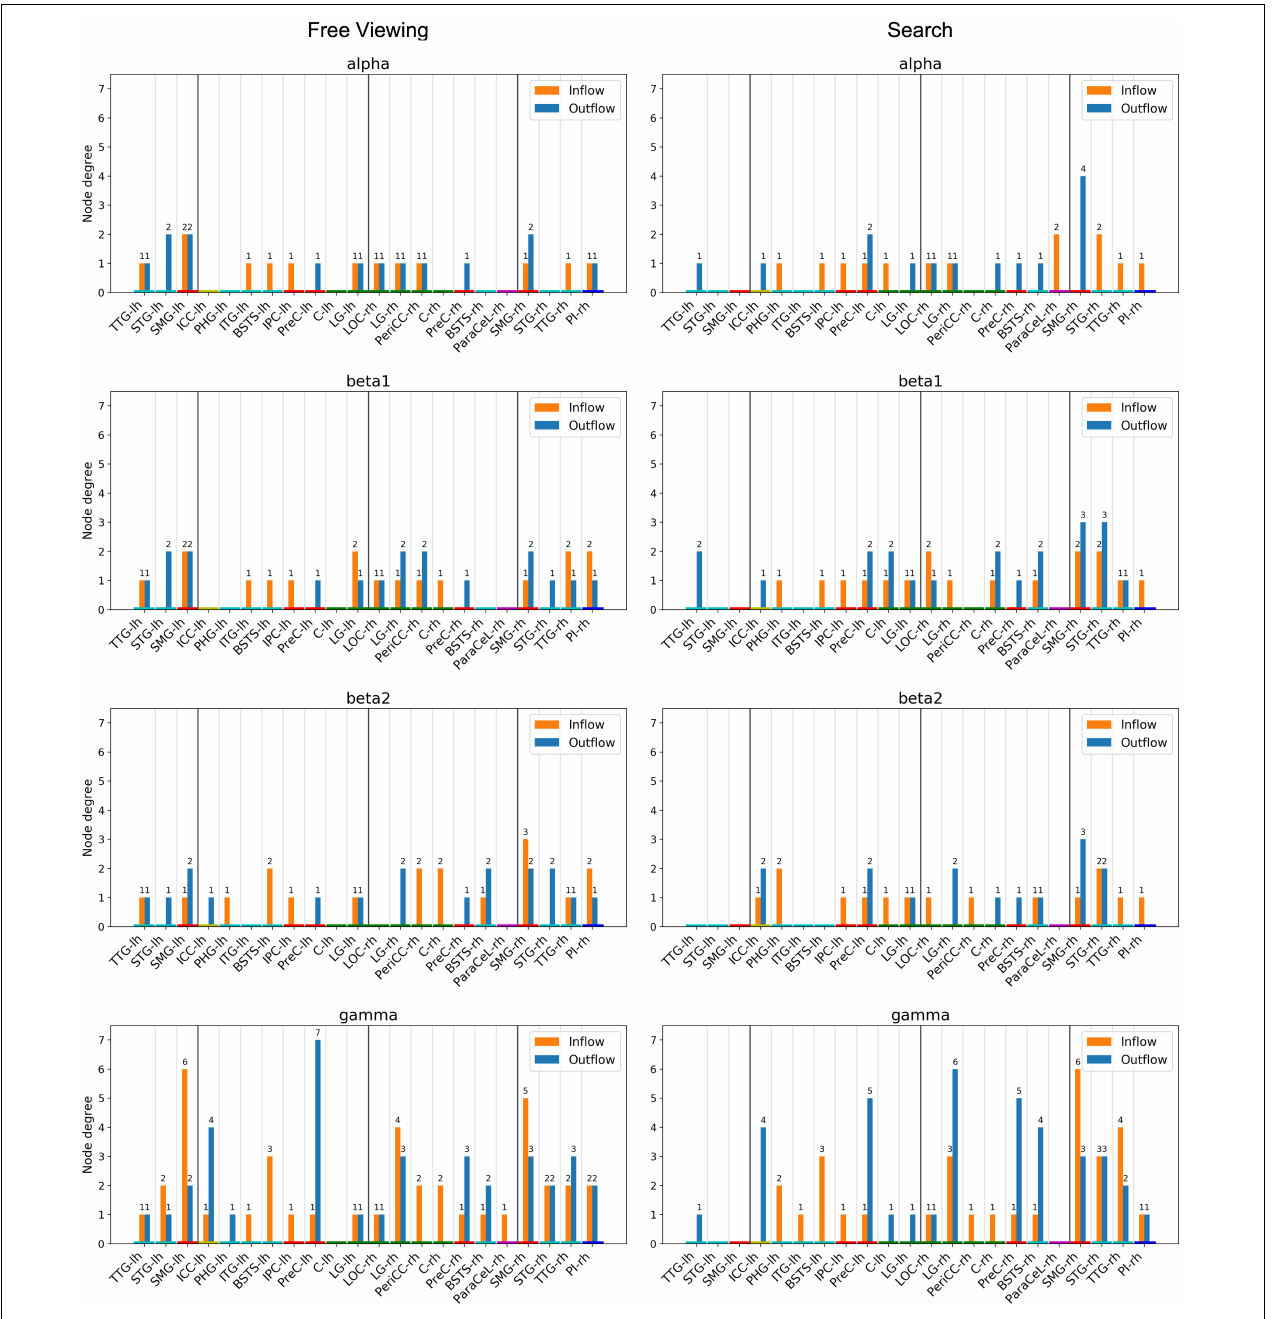
FIGURE 8 | Node degree, i.e., the number of incoming and outgoing connections per ROI. Only ROIs with a node degree equal to or above the 95th percentile in at least one frequency band for either task were included. The ROIs are ordered by hemisphere and cluster (TDC and DC). The color of the nodes indicates the anatomical higher-level regions (frontal lobe: magenta, insula: blue, cingulate cortex: yellow, temporal lobe: turquoise, parietal lobe: red, occipital lobe: green). Results from the delta and theta band can be found in Supplementary Material